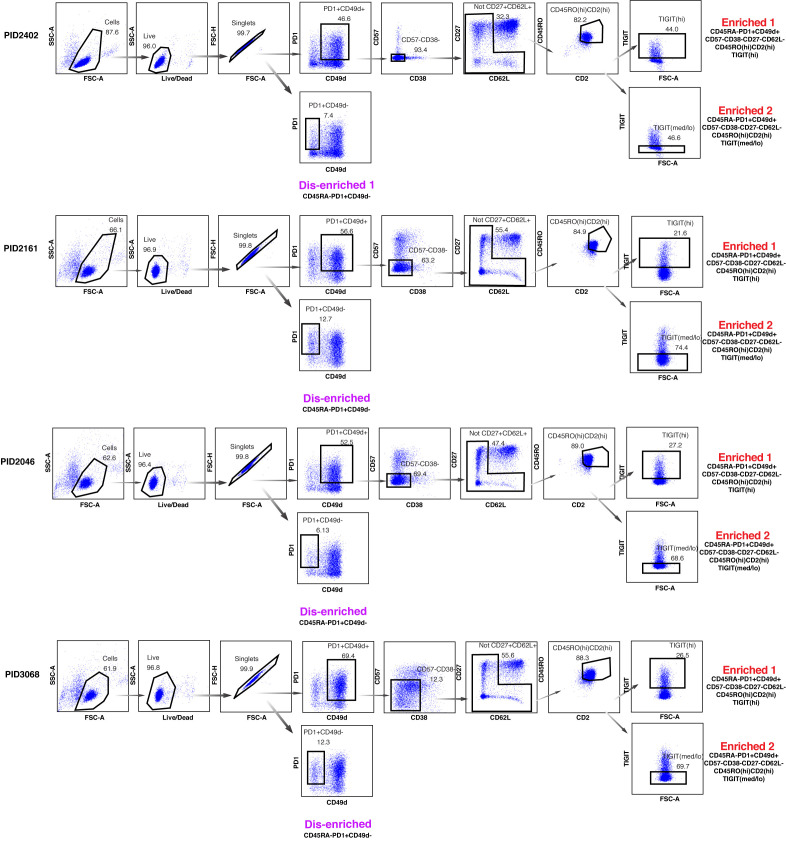
Implementation of the universal sort strategy to isolate three populations memory CD4+ PD1+ T cells harboring different frequencies of kNN latent cells from four untested donors.The universal sort strategy shown in Figure 6—figure supplement 5 was converted into a multiparameter sort panel and implemented on four new donors. Shown are the sequential FACS plots depicting the sorting that was used to isolate, from each donor, a single population of disenriched cells and two populations of enriched cells (TIGIThigh versus TIGITmed/low). Memory CD4+ T cells from each donor were purified by negative selection before sorting. The phenotypic features of each sorted population are depicted beneath the corresponding population.